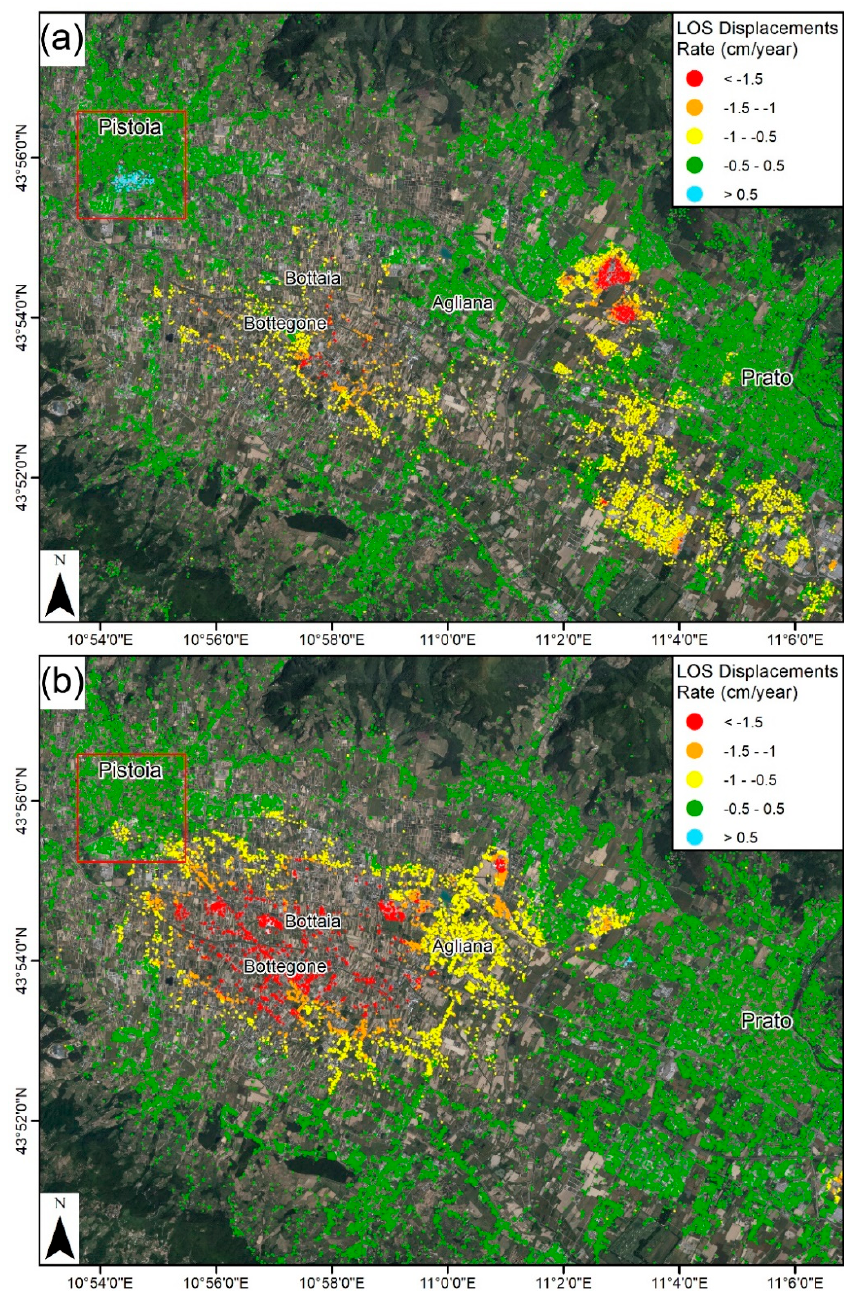
Figure 2. Land subsidence contours derived from ERS 1/2 ( a ) and ENVISAT ( b ) data, covering a time period spanning between 1992 and 2010. The red square represents the area of interest of this work where, starting from August 2016, a new lowering area has been discovered.